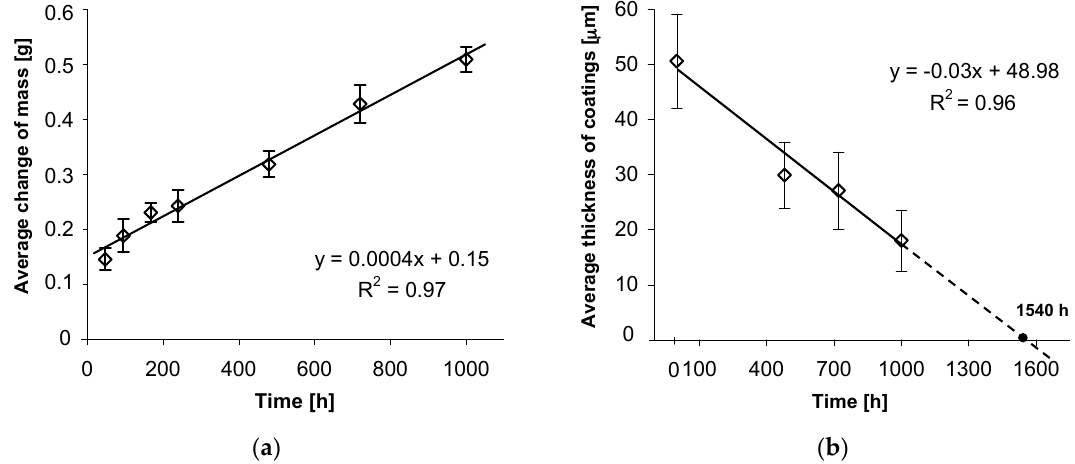
Figure 6. Average change of mass in tested bolts grade 10.9 ( a ) and average change of thermal diffusion coating thickness ( b ) during exposure in salt spray